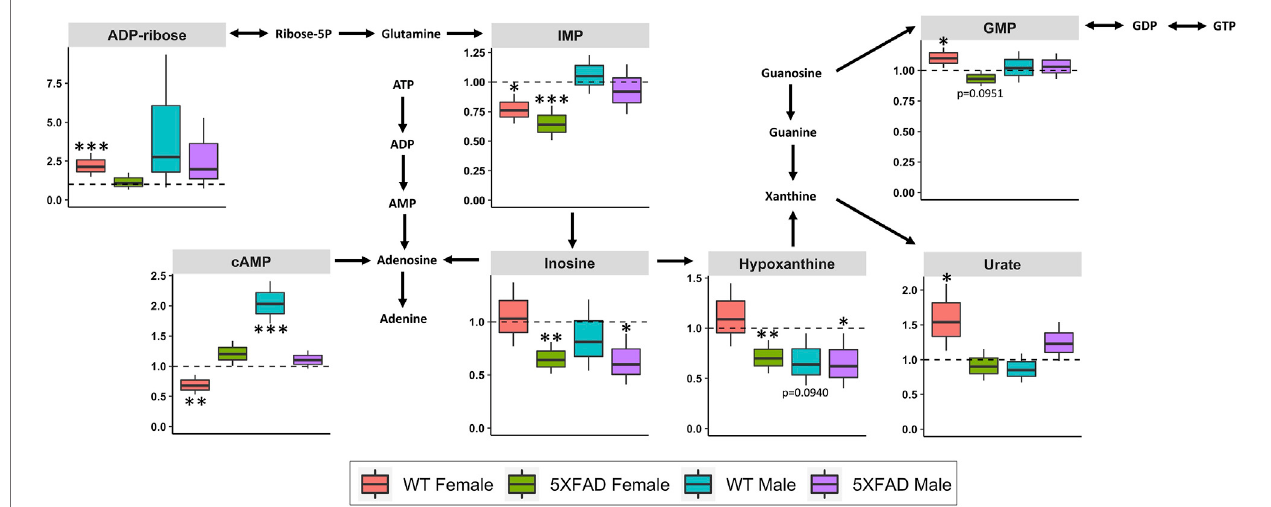
FIGURE 7 | Fold changes in cortical metabolites related to purine metabolism in male and female 5xFAD or wild-type (WT) mice following treatment with CAW (500 mg/kg) compared to sex- and genotype-matched untreated controls. * p < 0.05, ** p < 0.005, *** p < 0.001.